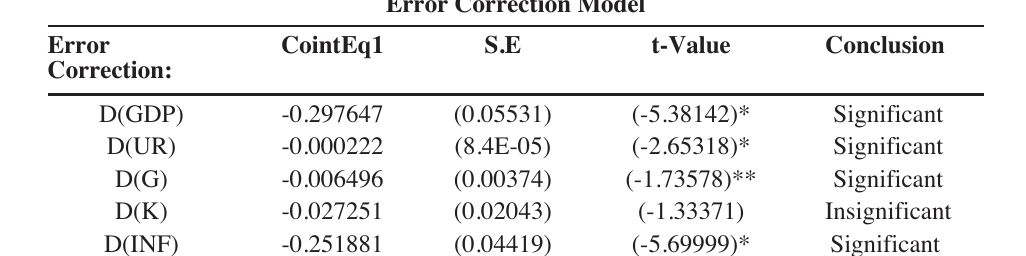
Error Correction